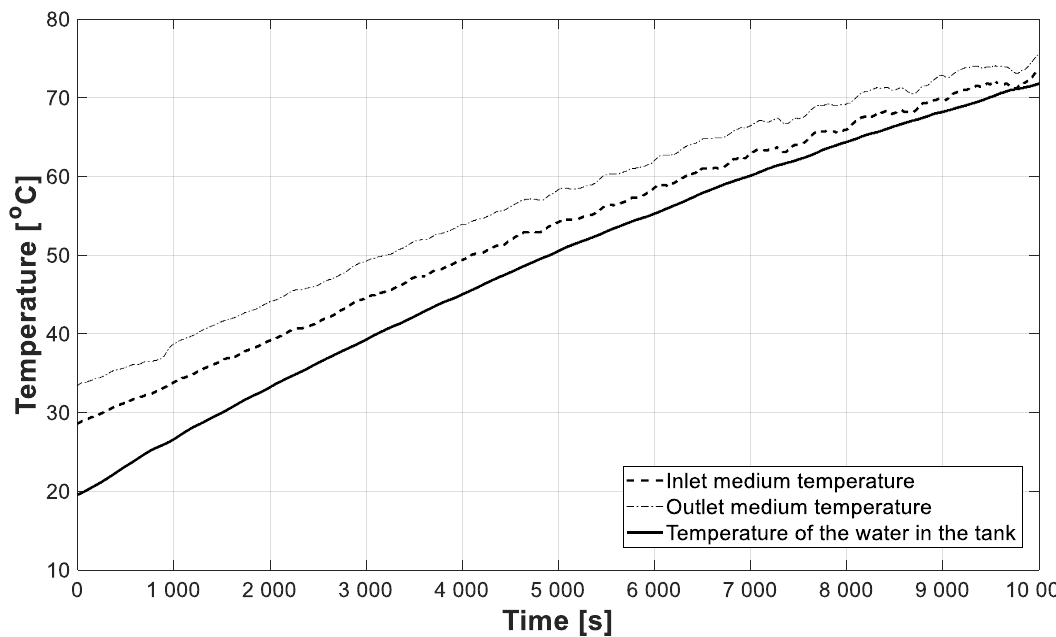
Figure 7. Operating data for inlet and outlet temperatures of the medium and water in the storage tank.